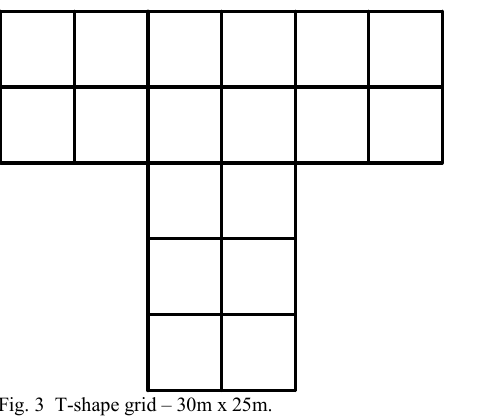
Fig. 3 T-shape grid – 30m x 25m.